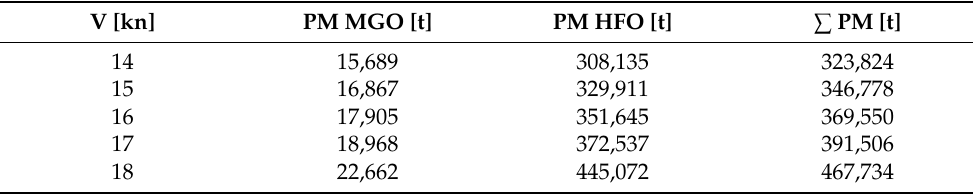
Table 10. Estimated amount of PM emissions generated by container shipping in